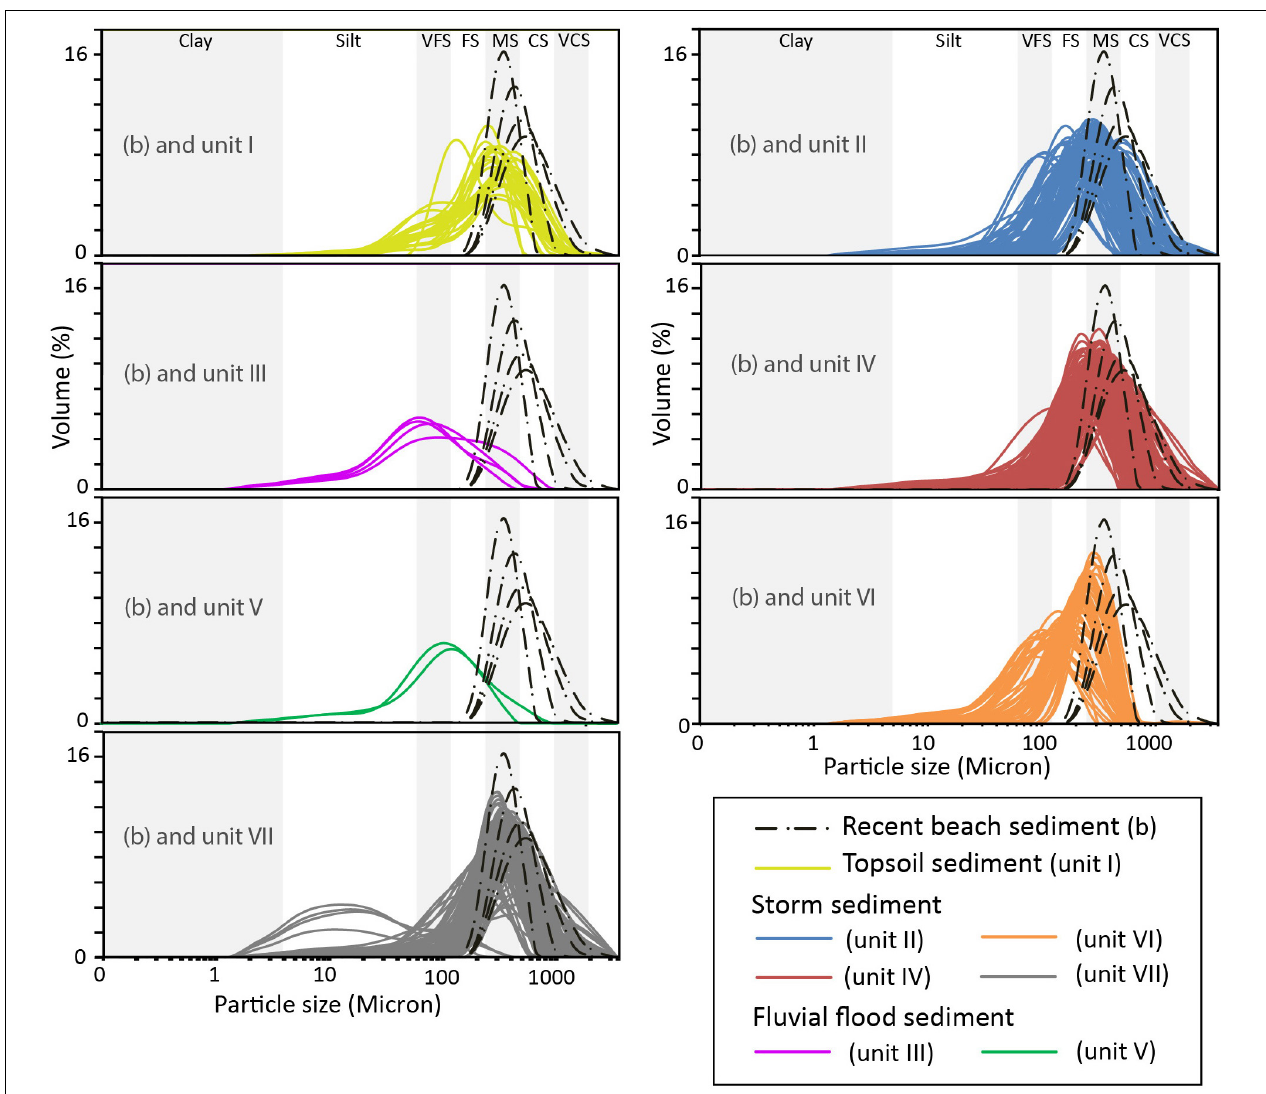
FIGURE 8 | Plots of the grain size distribution curves of Units I–VII in comparison with the shore-normal beach deposits (b) (location in Figure 1C ). The number of grain size distribution curves in each unit is as follows: recent beach ( n = 4), Unit I ( n = 27), Unit II ( n = 97), Unit III ( n = 4), Unit IV ( n = 177), Unit V ( n = 2), Unit VI ( n = 69), and Unit VII ( n = 94). The characteristic of the grain size distribution of the storm sediments shows curves that are consistent with the curves of the shore-normal recent beach sediments in the range of coarse-to-medium sand, whereas the grain size curves of the FF sediments are different, being distributed in the range of very-fine sand to